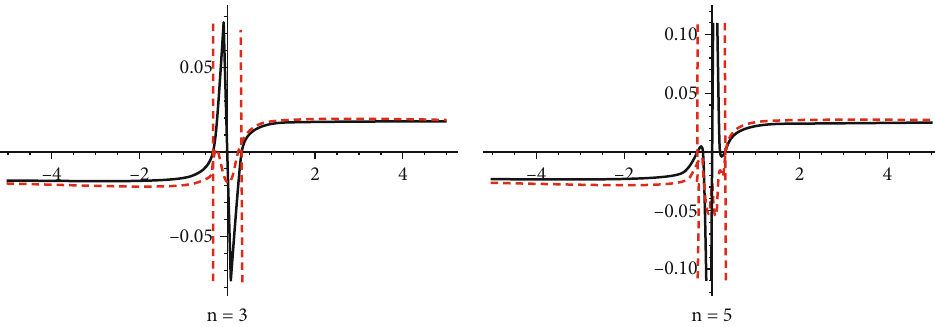
Figure 4: Solid lines represent ð TB Þ both normalized by the factor ð 1 + j x / α j n Þ